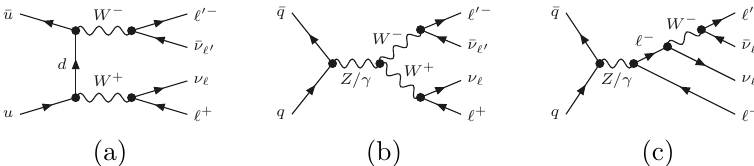
Figure 1 . Sample of Born diagrams contributing to 2 ‘ 2 (cid:23) production in the di(cid:11)erent-(cid:13)avour case ( ‘ = ‘ 0 ) and in the same-(cid:13)avour case ( ‘ = ‘ 0 ). Both double-resonant (a,b) and single-resonant (c) 6 diagrams are shown.